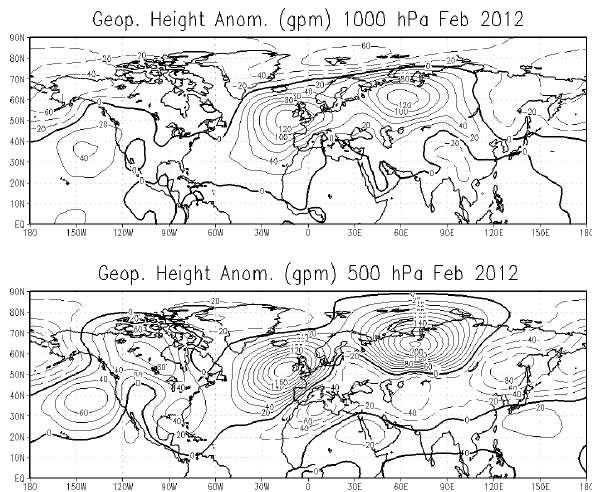
Fig. 2. As Fig. 1 but for February 2012.